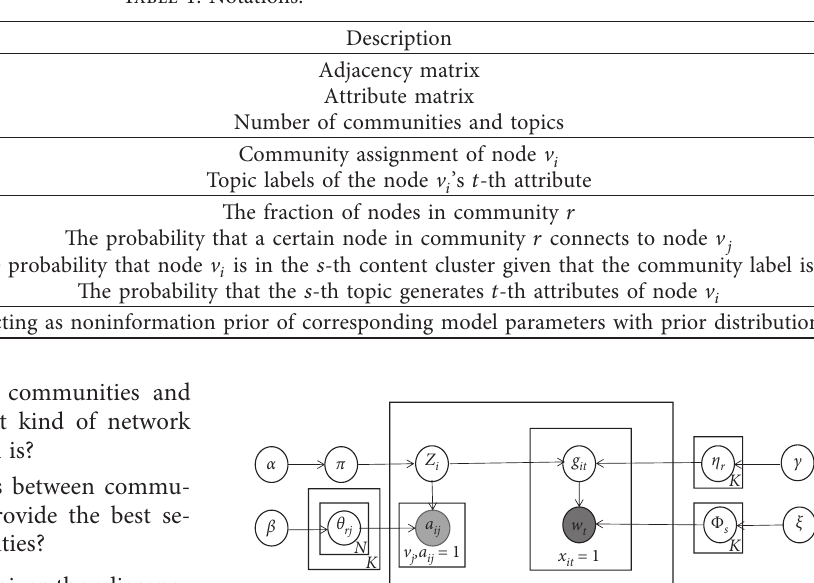
Table 1: Notations.